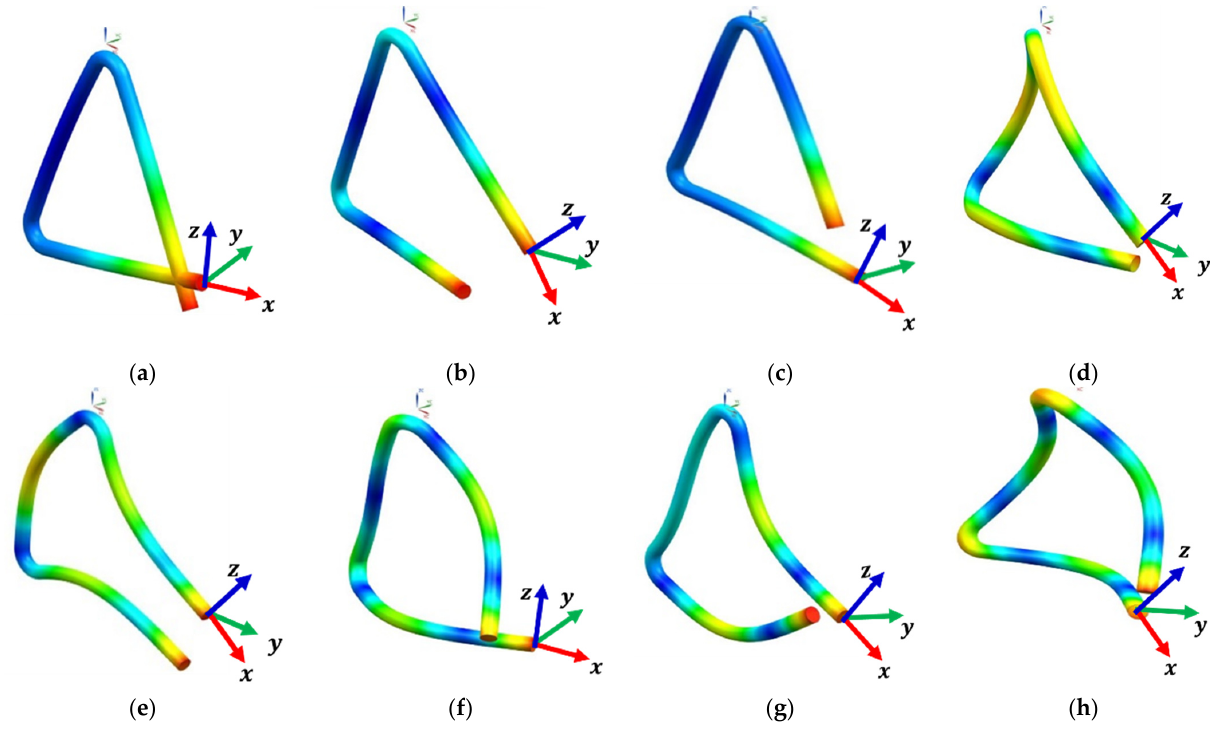
Figure 11. Vibration modes of the triangle T2: ( a ) mode 1 (168 Hz); ( b ) mode 2 (172.75 Hz); ( c ) mode 3 (300 Hz); ( d ) mode 4 (878 Hz); ( e ) mode 5 (1056.66 Hz); ( f ) mode 6 (1560.88 Hz); ( g ) mode 7 (1601.97 Hz); ( h ) mode 8 (1812 Hz).